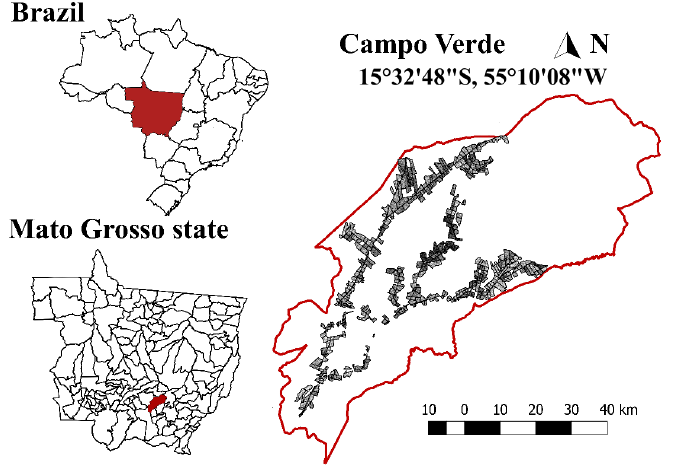
Figure 4. Campo Verde, Brazil(taken with permission from